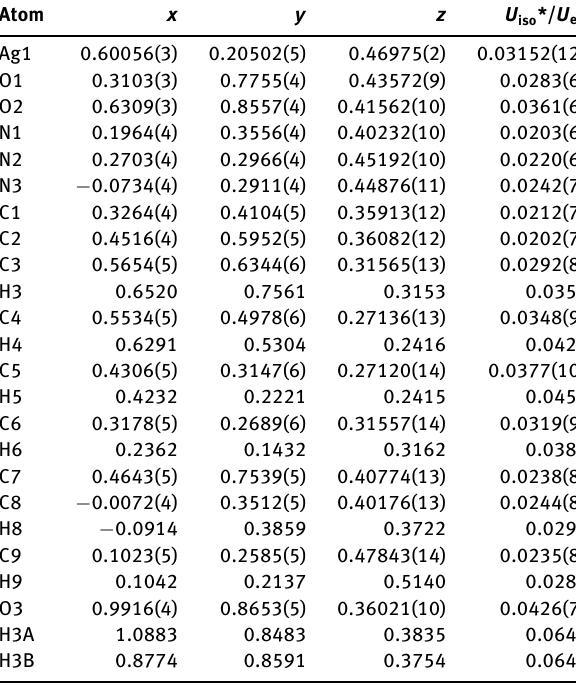
Table 2: Fractional atomic coordinates and isotropic or equivalent isotropic displacement parameters (Å 2 ).